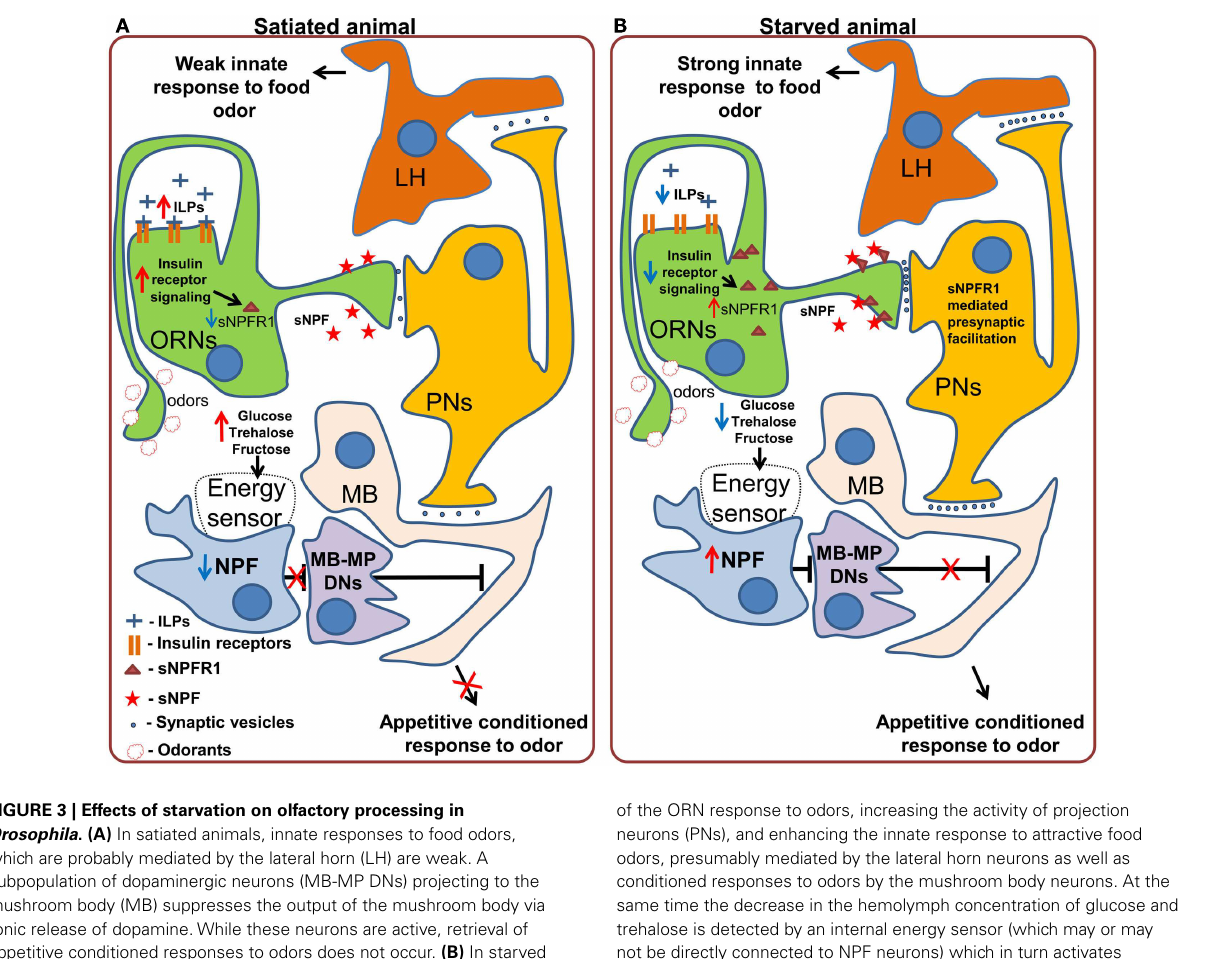
FIGURE 3 | Effects of starvation on olfactory processing in Drosophila . (A) In satiated animals, innate responses to food odors, which are probably mediated by the lateral horn (LH) are weak. A subpopulation of dopaminergic neurons (MB-MP DNs) projecting to the mushroom body (MB) suppresses the output of the mushroom body via tonic release of dopamine.While these neurons are active, retrieval of appetitive conditioned responses to odors does not occur. (B) In starved animals, the inhibition of Insulin-like receptor (InR) signaling in the olfactory receptor neurons (ORNs) stimulates the synthesis and incorporation of Short Neuropeptide F Receptor type 1 (sNPFR1) into the membrane of these neurons. sNPFR1 mediates presynaptic facilitation